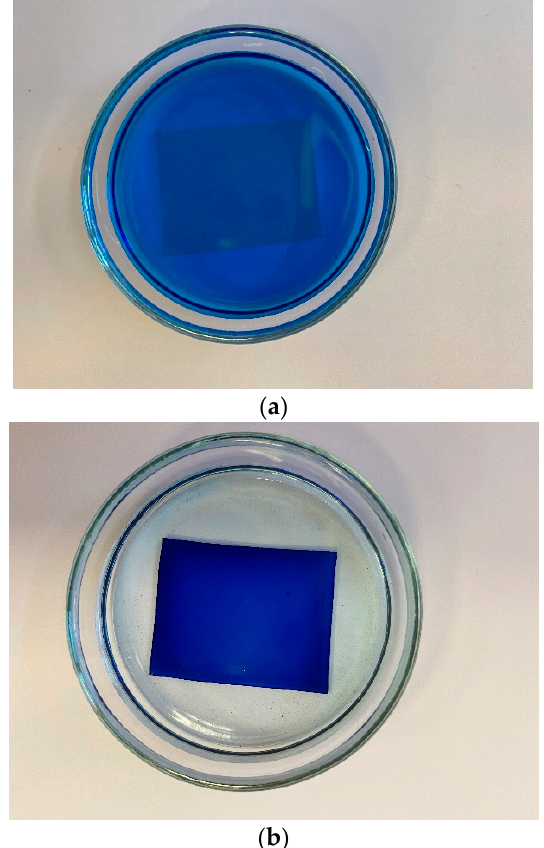
Figure 1. The process of soaking Nafion in the MB solution with concentration 0.015 mg/mL. Panel ( a ) corresponds to the start of soaking. Panel ( b ) corresponds to the end of soaking.